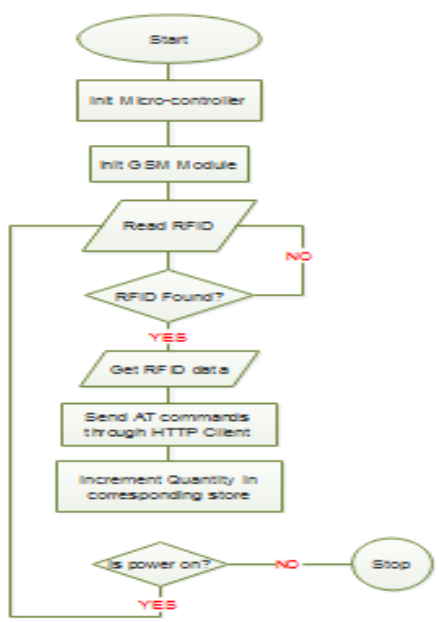
Fig. 2. Proposed Algorithm of the Grain Tallying using